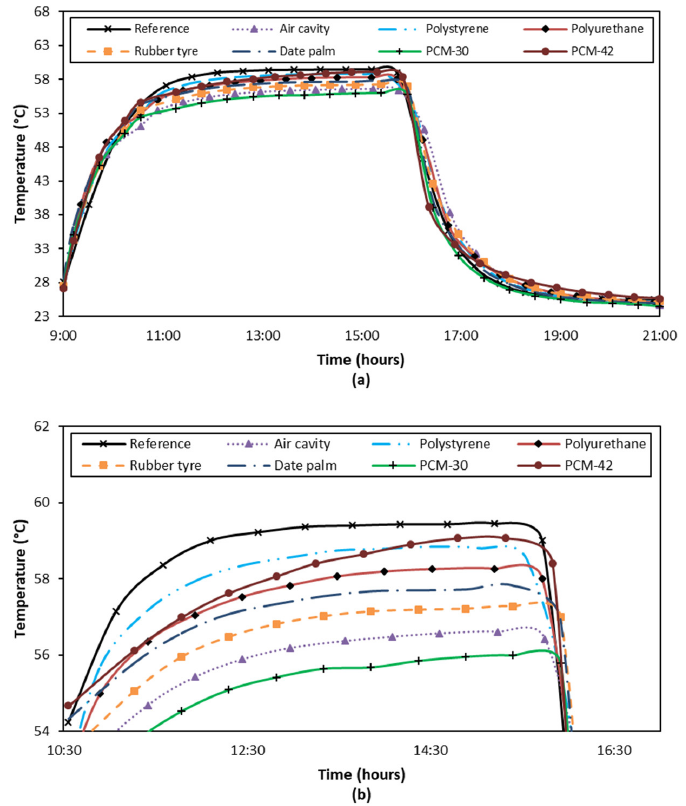
Figure 3. Thermal performance curves for front surface, ( a ) from start to end and ( b ) at the steady state. The difference of back surface temperature for all compositions was significant with respect to the reference sample as represented in Figure 4. At the back surface, reference concrete achieved steady state at 39.5 °C. It was 33.2 °C for air cavity which is obvious that K-value of air is very low compared with concrete. Other reason is that in the case of a solid concrete cube, heat transmission was due to conduction while through air, convection and radiation is dominant mode of heat transfer. Among all materials, back surface temperature remained lower for the case of PCM-30 for the longer time. It is due to the melting of PCM in the range of 27 °C to 33 °C. In the case of PCM-42, the material behaved only as a thermal mass and it conducted heat with the sensible rise in temperature. The benefits of latent heat of PCM for energy storage can be exploited if temperature swings across the surfaces are high and enough heat flux is struck on the surface that can melt PCM. It happened only in the case of PCM-30 because temperature rose to that level and the curve for PCM-30 stayed in its melting range for approximately 2 h. In earlier studies, application of phase change material and polystyrene foam (as conventional insulation material) in the form of multilayered wall was investigated in the hot climatic conditions of UAE. The research reported a temperature drop of 8.5% at the maximum at the indoor space and shifted off the peak by 2.6 h with the overall energy benefits of 44% reduction in heat gain [22]. Recently, PCM as an insulation contained in the aluminum frame was stacked on the inner surfaces of a room and the thickness of the PCM was varied to test its effect on the energy performance [24]. Through the investigations, a temperature drop of 3.32 °C in the indoor air was achieved at the maximum. Simultaneously, the cooling load in the maximum case was lowered by 20.9% using 1cm thick PCM layers in all walls and roofs for the peak hour [24]. A similar study was conducted in the central United States exploiting PCM to reduce heat flux to indoor space. On average, the peak heat flux was delayed by 1.5 h and the magnitude of the heat flux was decreased by 38.5% at the maximum [25].